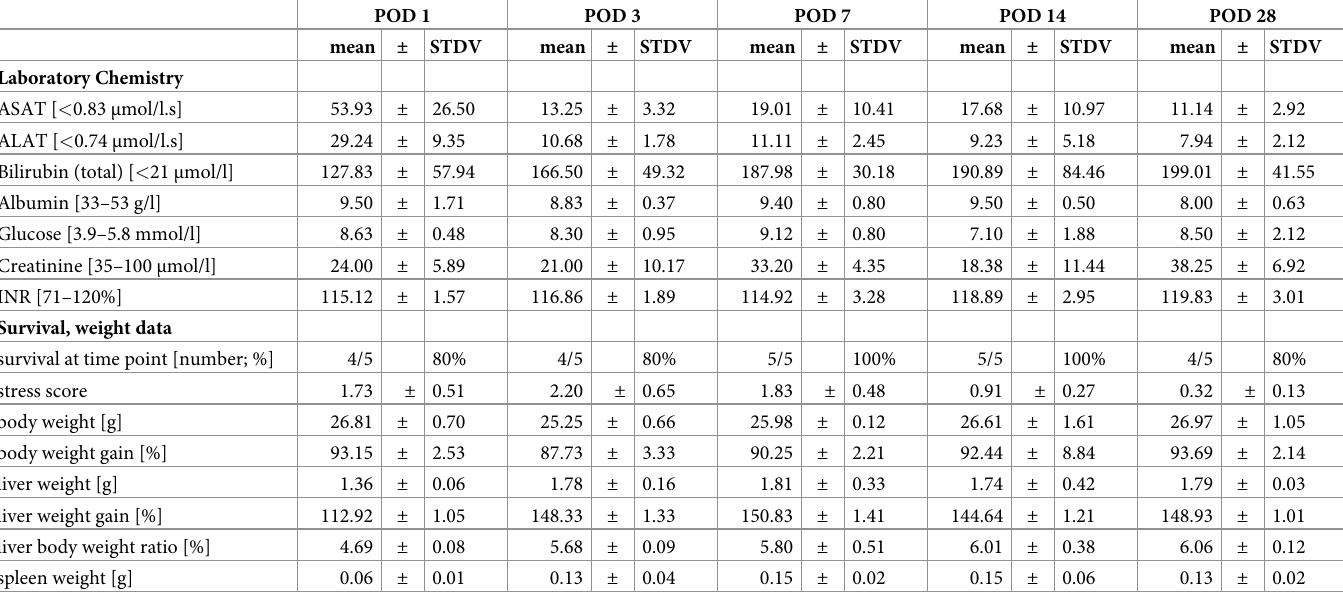
Table 3. Results of laboratory chemistry and data of survival and weight data after tBDT in